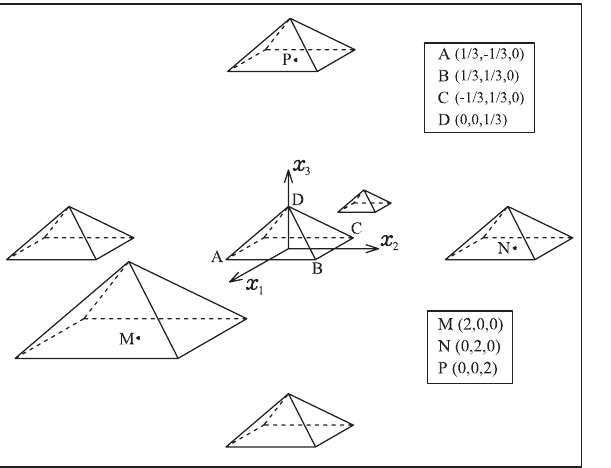
Figure 6 Variations of the total strain component, ε component, σ , with x within the x 11 1 = 1. along x 2